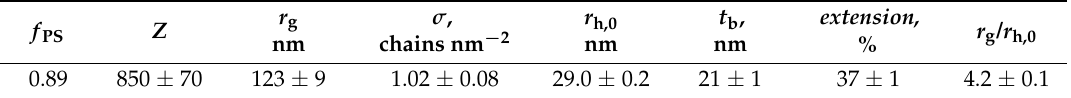
Figure 2. ( A ) Dispersibility tests for PS/PMMA-CdS in solvents of different polarities and ( B ) UV–Vis spectra of PS/PMMA-CdS dispersed in chloroform (blue), toluene (red), and THF (black). Table 1. Structural Characteristics of PS/PMMA–CdS from SLS and DLS in THF.